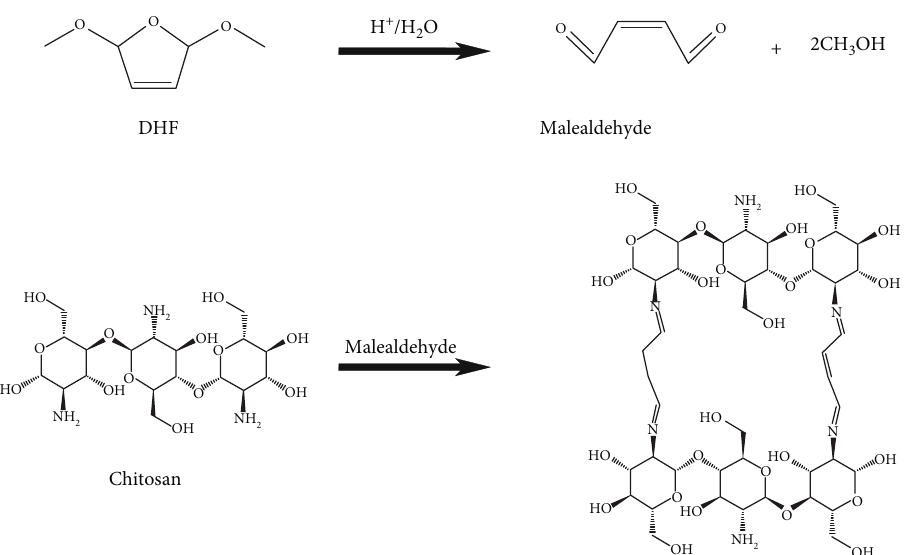
Figure 4: Chitosan cross-linked by the Schi ff base reaction between malealdehyde and amine moieties of